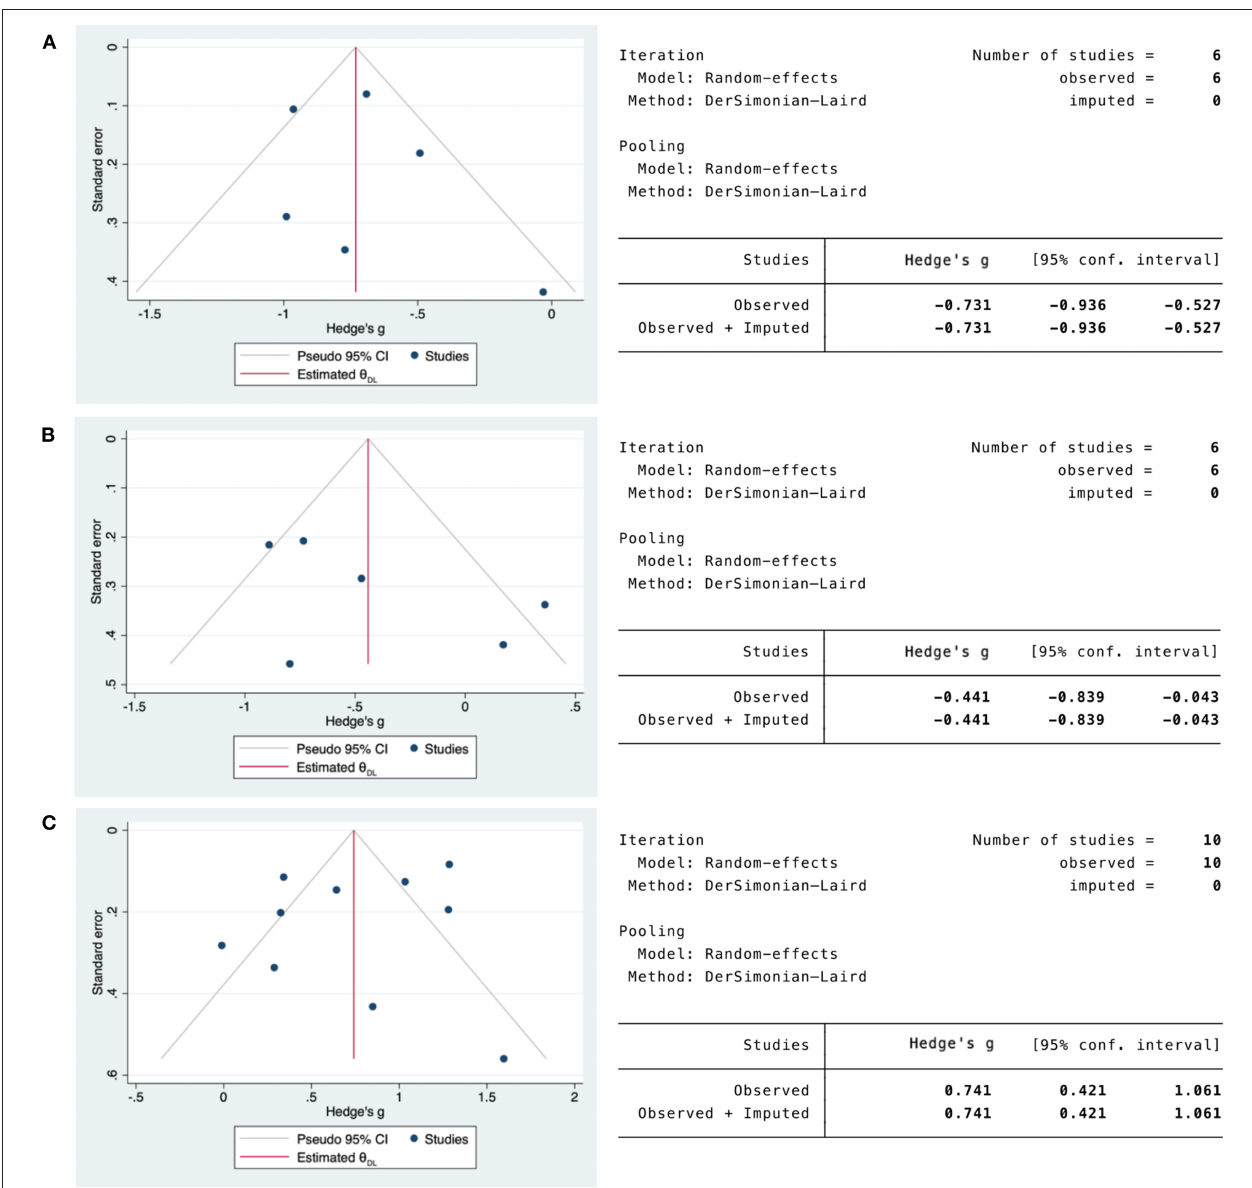
FIGURE 8 | Non-parametric trim and fill funnel plot analysis of publication bias for CD4/CD8 T-cells and IL-10 in COVID-19 mortality studies. (A) CD4 T-cells in COVID-19 mortality studies. (B) CD8 T-cells in COVID-19 mortality studies. (C) IL-10 in COVID-19 mortality studies. Observed studies (blue). Imputed studies (orange).